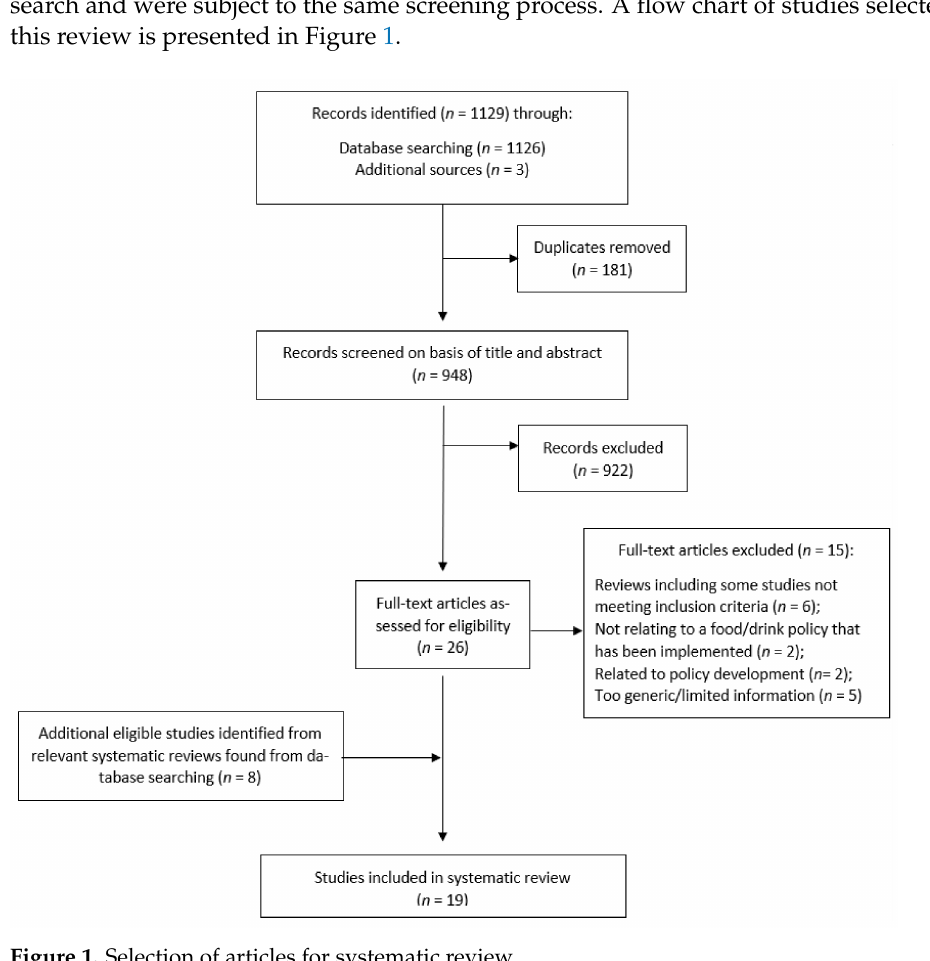
Figure 1. Selection of articles for systematic